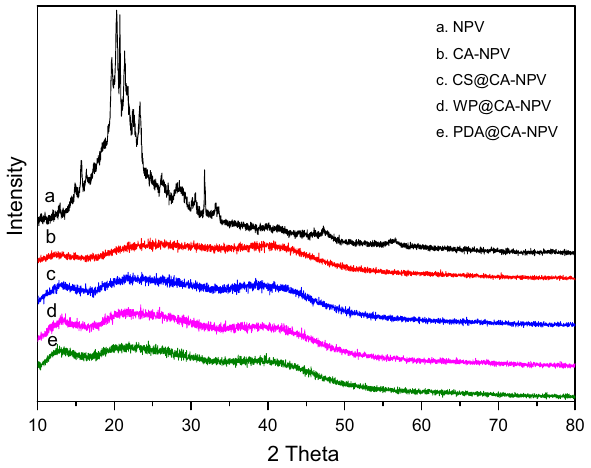
Figure 3. XRD patterns of SeMNPV and microencapsulated preparations. Freeze-dried samples were ground and pressed into 1 mm thick circular slices, which were tested by XRD. The test parameters were set as follows: copper target, input = 1.5418 A, 40 kV pipe pressure, 40 mA pipe current, diffraction angle from 2θ to 80°, scanning rate 2°/min. the SeMNPV has a sharp diffraction peak and a flat baseline, which is expressed as a